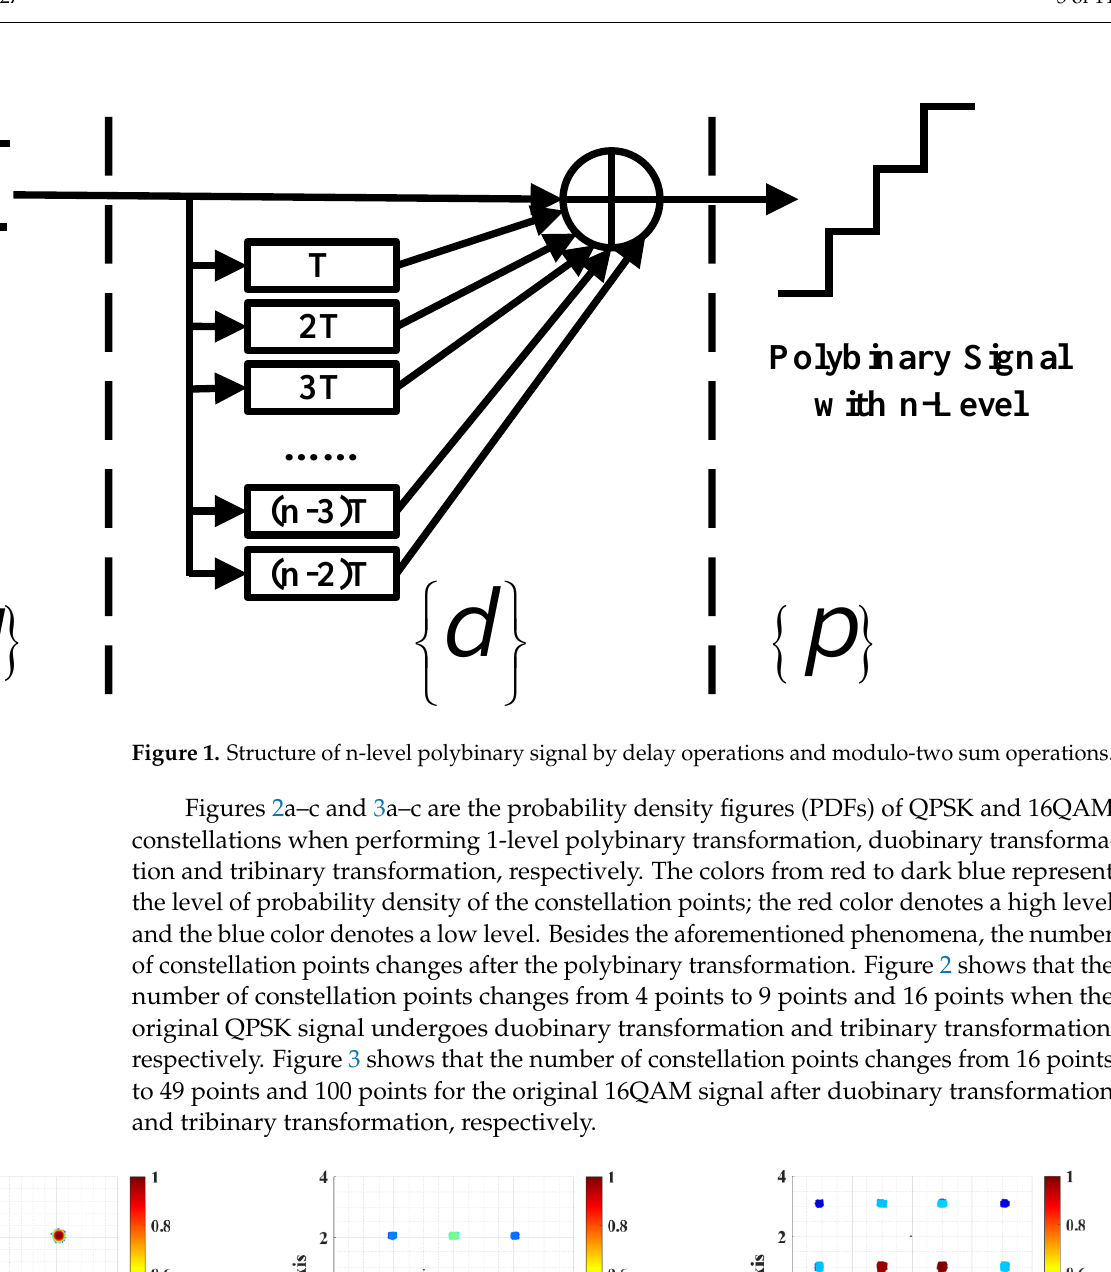
Figure 1. Structure of n-level polybinary signal by delay operations and modulo-two sum opera- tions.